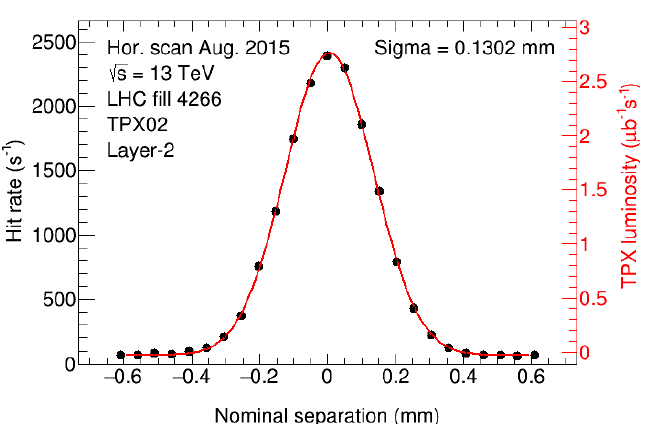
Figure 34. Luminosity from hit-counting as a function of nominal beam separation measured with TPX02 layer 2 during the first horizontal vdM scan in August 2015. Each data point shows the measured instantaneous luminosity before background subtraction. Because the exposure time is significantly shorter than the duration of a scan step, the TPX samplings are averaged per scan step. The TPX samplings that partially or totally overlap with non-quiescent scan steps (varying beam separation) are not shown. The fit function is the sum of a single Gaussian (representing the proper luminosity in this scan) and a constant term that accounts for instrumental noise and single-beam background. The TPX normalization uses this horizontal and a vertical beam width from LHC vdM fill 4266. Taken from Ref. [14].